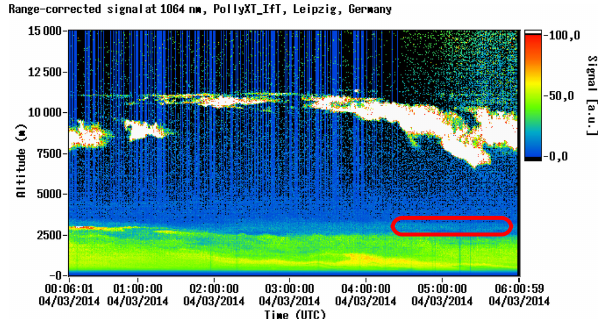
Table 5. Comparison of sulfate concentration computed from lidar measurements, CAMS data and FLEXPART for layers at lidar sta- tions associated with layers from Pillersdorf, 4 April 2014,